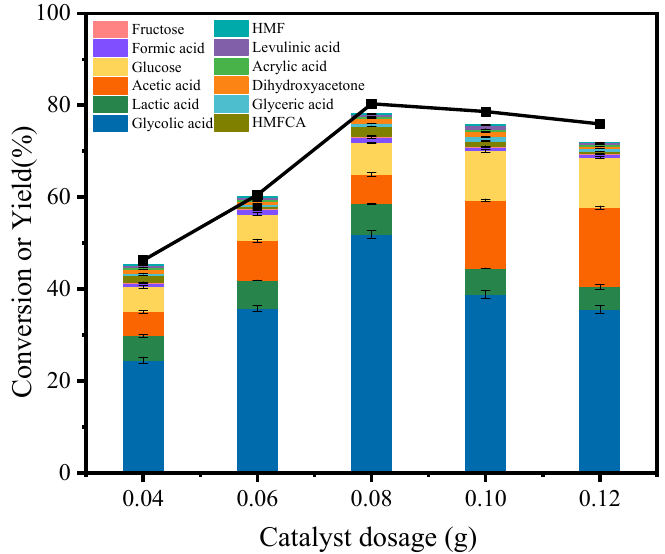
Figure 11. The effect of catalyst dosage on the catalytic activity of Bi/ β -2 catalyst. Reaction conditions: cellulose 0.1 g, water 12 mL, 180 ◦ C, 10 h, 2 MPa O 2 .